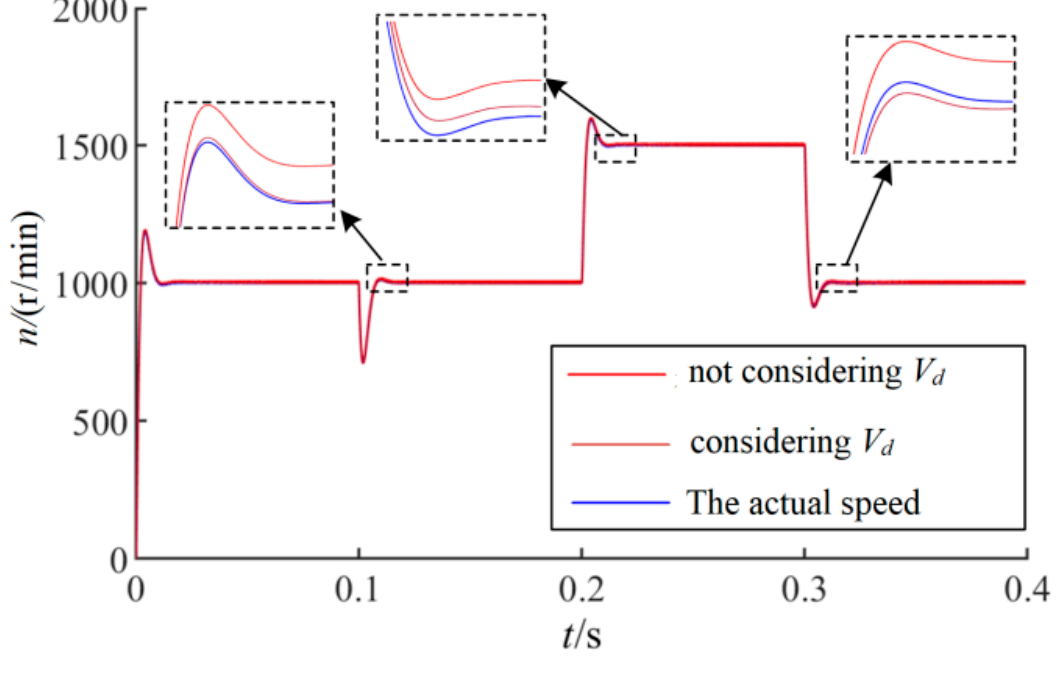
Figure 4. Speed simulation curve.